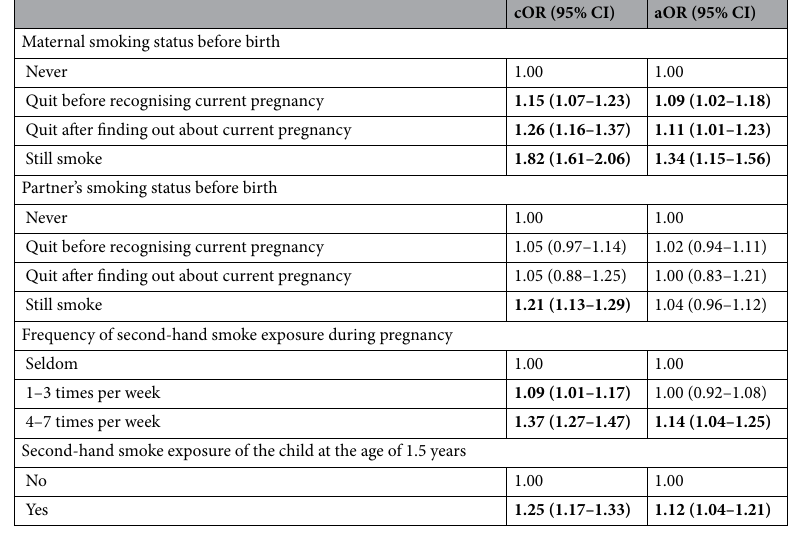
Table 1. Association between smoking exposure and risk of bronchial asthma at the age of 3 years. cOR, crude odds ratio; aOR, adjusted odds ratio; CI, confidence interval. Boldface indicates statistical significance (p < 0.05). Adjusted for maternal and partner’s smoking status before birth, frequency of second-hand smoke exposure during pregnancy, maternal history of bronchial asthma, maternal age at birth, pre-pregnancy body mass index, maternal educational level, child’s sex, gestational age at birth, mode of delivery, attendance to childcare facility at 1 year of age, breastfeeding at 1 year of age, and older siblings.